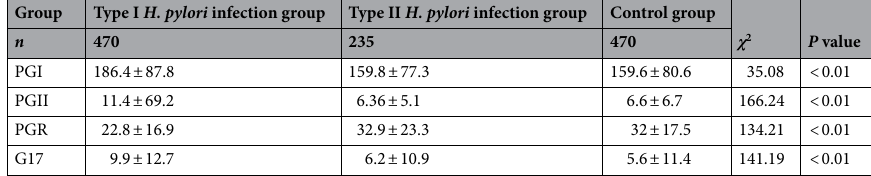
Table 3. The effect of different types of H. pylori infection on three items of serum gastric